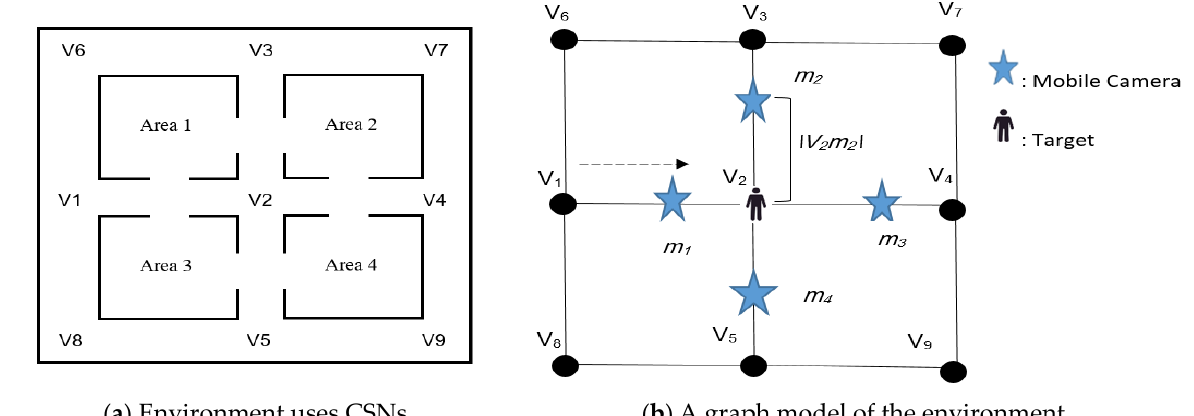
Figure 2. An example of CSN environment and its graph model. Example: As shown in Figure 2, assume the target is moving from V 1 toward V 3